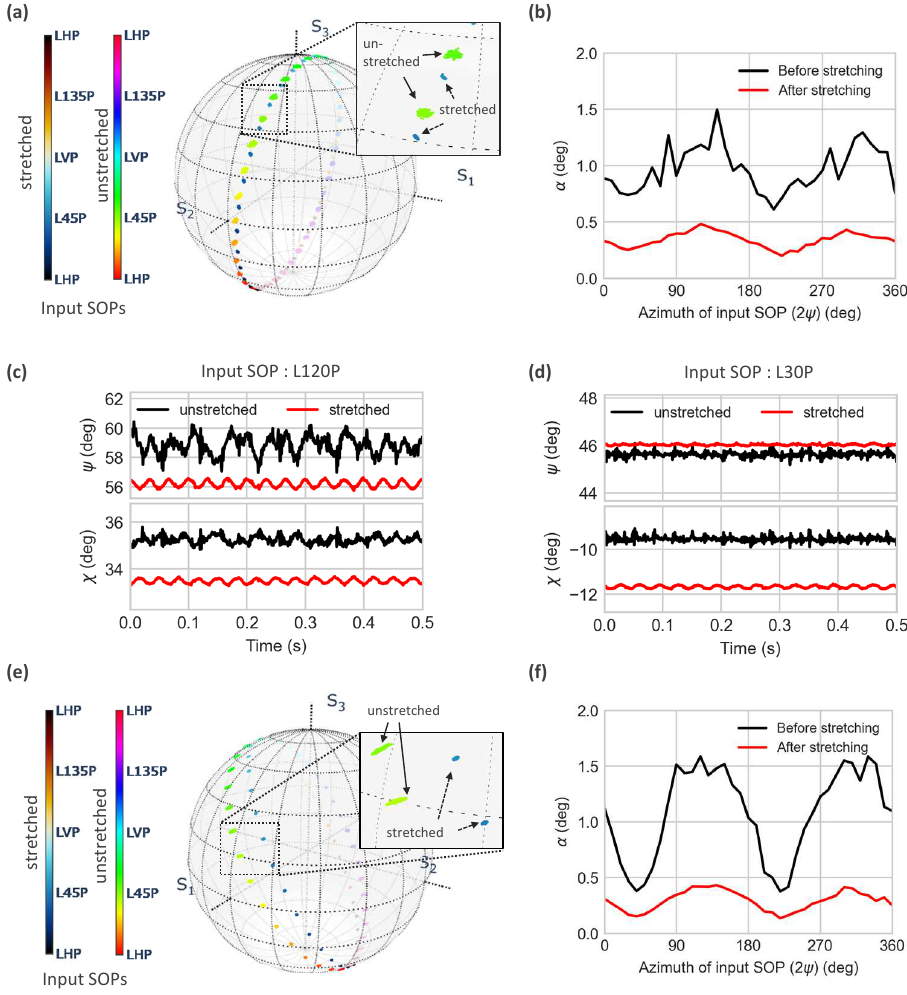
Figure 7. ( a ) Measured vibration-induced SOP change in the lo-bi spun fiber displayed on the Poincaré sphere. To investigate the input SOP dependence, the azimuth of the linear SOP was scanned from 0 to 360 ◦ . The collision effect was also investigated by comparing the SOP change before and after stretching the fibers. The inset is a zoomed-in image for a linear 45 ◦ input SOP. ( b ) Calculated relative SOP changes ( α ) as a function of the input SOP. ( c ) Measured temporal SOP evolution before (black) and after stretching (red) for a 120 ◦ linear input SOP. ( d ) Measured temporal SOP evolution before (black) and after stretching (red) for a 30 ◦ linear input SOP. ( e ) Vibration- induced SOP change for the hi-bi spun fiber measured under same conditions as those for the lo-bi fiber. The inset is a zoomed-in image for a linear 45 ◦ input SOP. ( f ) Relative SOP changes calculated from the measured Stokes